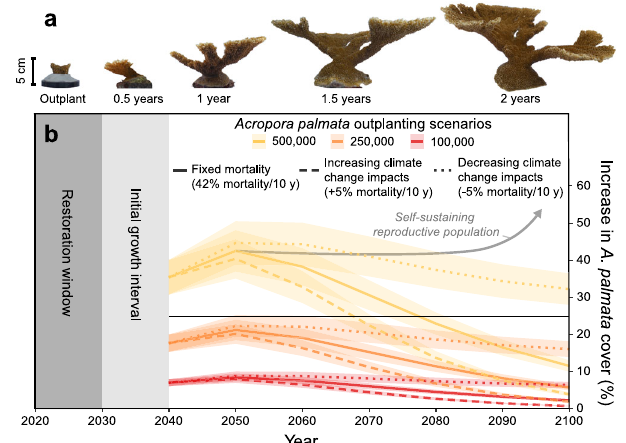
Fig. 2 | Illustration of the rapid growth of Acropora palmata and its potential for increasing coral cover through restoration. a Example photographic time- series showing the growth of a colony of A. palmata at Buck Island Reef National Monument(BIRNM)overtwoyears 30 . b Modeledmean(±standarderror)increases in the percent cover of A. palmata on the BIRNM reef crest following three sce- narios of reef-crest restoration until 2030 and three scenarios of post-restoration mortality (see Methods). The model indicates that a single large-scale restoration effort now could allow reefs at BIRNM to maintain high levels of coral cover until around 2050; however, additional local management, global reduction of carbon emissions, and/or the recovery of ecological processes like sexual reproduction (illustrated conceptually by the gray arrow) or a decrease in climate-related impacts, potentially through acclimatization and/or increased resilience (dotted lines), would be necessary to maintain stable coral populations in the long term. Thehorizontallinein b denotestheminimumincreasein A.palmata cover(25%,to ≥ 31% total cover) our carbonate budgets suggest is needed for